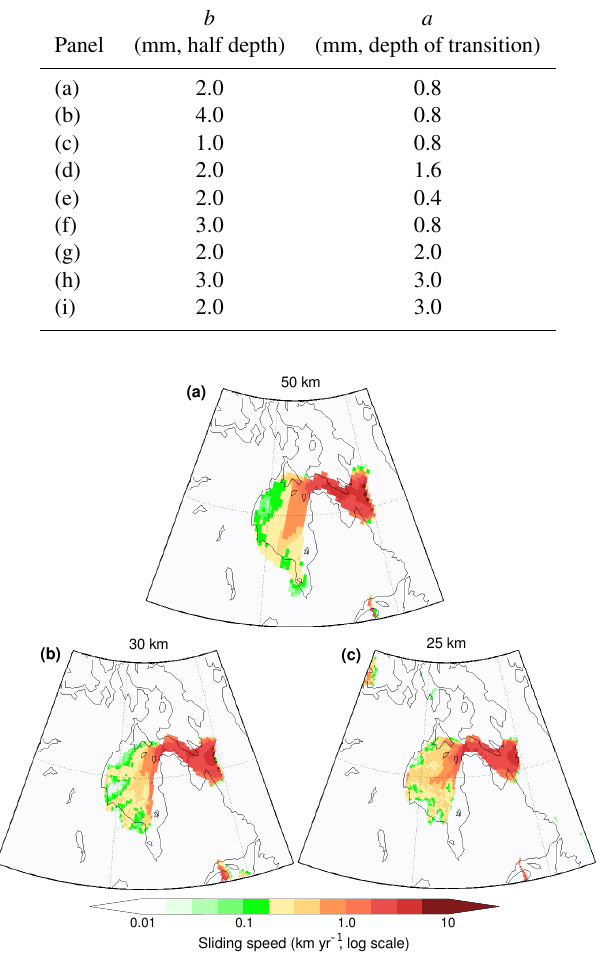
Table 2. Values of parameters used in the sensitivity test of Eq. (1) shown in Fig.10. Panels refer to the panel in Fig.10. b and a are the parameters in Eq. (1) and represent the depth at which the sliding parameter takes a value of C 0 and the depth over which the transi- 2 tion occurs, respectively.